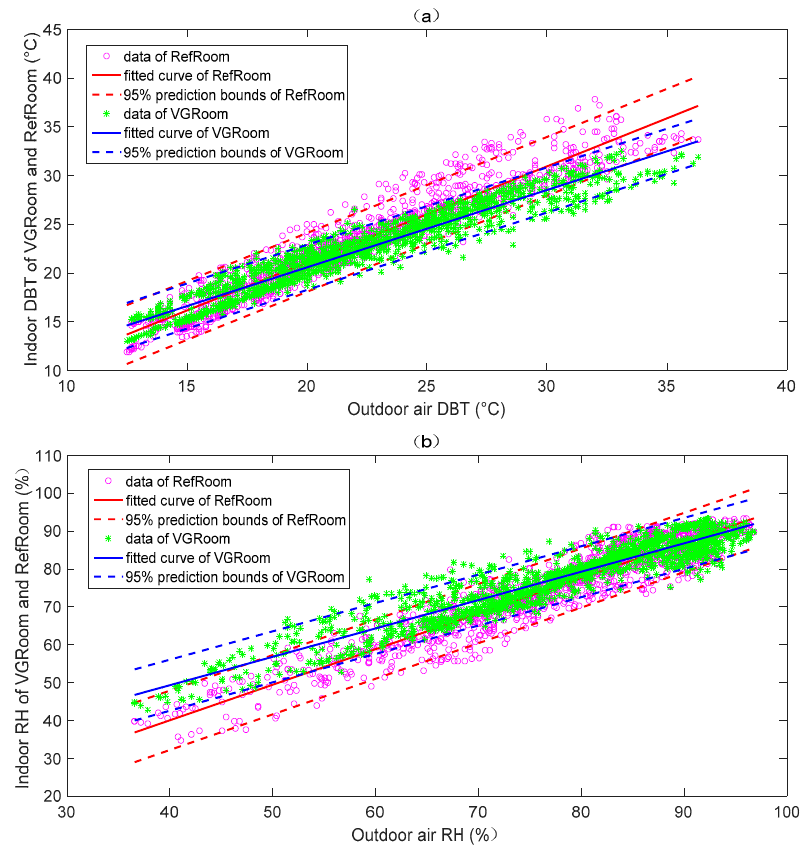
Figure 11. Relationships between ( a ) indoor and outdoor DBT and ( b ) indoor and outdoor RH values. Table 5. Results of the linear fitting.